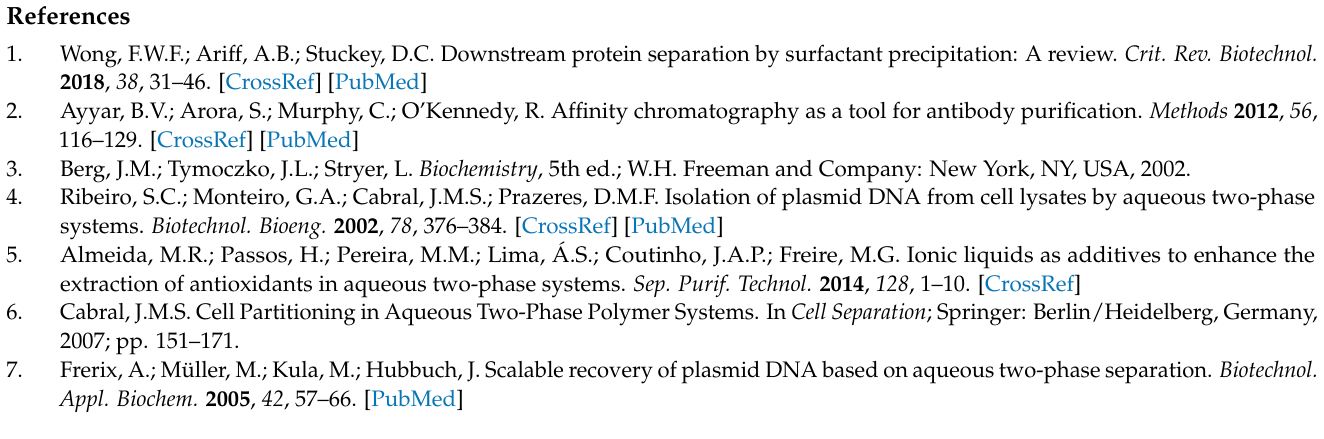
binodal curves of the ABS formed by [C 4 mim][MES] (1) + K 2 HPO 4 /KH 2 PO 4 (2) + H 2 O (3) at (25 ± 1) ◦ C and pH 7. Table S2: Experimental weight fraction data for the binodal curves of the ABS formed by [N 4444 ][MES] (1) + K 2 HPO 4 /KH 2 PO 4 (2) + H 2 O (3) at (25 ± 1) ◦ C and pH 7. Table S3: Experimental weight fraction for the binodal curves of the ABS formed by [P 4444 ][MES] (1) + K 2 HPO 4 /KH 2 PO 4 (2) + H 2 O (3) at (25 ± 1) ◦ C and pH 7. Table S4: Experimental weight fraction for the binodal curves of the ABS formed by [N 4444 ][Arg] (1) + K 2 HPO 4 /KH 2 PO 4 (2) + H 2 O (3) at (25 ± 1) ◦ C and pH 7. Table S5: Experimental weight fraction for the binodal curves of the ABS formed by [P 4444 ][Arg] (1) + K 2 HPO 4 /KH 2 PO 4 (2) + H 2 O (3) at (25 ± 1) ◦ C and pH 7. Table S6. Experimental weight fraction for the binodal curves of the ABS formed by [C 4 mim][Ac] (1) + K 2 HPO 4 /KH 2 PO 4 (2) + H 2 O (3) at (25 ± 1) ◦ C and pH 7. Table S7. Experimental weight fraction for the binodal curves of the ABS formed by [N 4444 ][Ac] (1) + K 2 HPO 4 /KH 2 PO 4 (2) + H 2 O (3) at (25 ± 1) ◦ C and pH 7. Table S8: Experimental weight fraction for the binodal curves of the ABS formed by [P 4444 ][Ac] (1) + K 2 HPO 4 /KH 2 PO 4 (2) + H 2 O (3) at (25 ± 1) ◦ C and pH 7. Table S9: Correlation parameters of Equations (1) and (2) used to describe the experimental binodal curve of the system. Table S10: Data of TLs and TLLs for the systems composed of IL + K 2 HPO 4 /KH 2 PO 4 buffer at pH 7 + H 2 O. [IL] and [salt] represents the compositions of IL and salt, respectively and content of water corresponds to the amount required to reach 100 wt%. Figure S15: Phase diagrams for the systems composed of IL + K 2 HPO 4 /KH 2 PO 4 buffer at pH 7 + H 2 O at 25 ◦ C: [C 4 mim][MES] ( • ); [N 4444 ][MES] ( (cid:7) ); [P 4444 ][MES] ( (cid:78) ); [N 4444 ][Arg] ( (cid:78) ); [P 4444 ][Arg] ( (cid:7) ); [C 4 mim][Ac] ( (cid:7) ); [N 4444 ][Ac] ( (cid:4) ); [P 4444 ][Ac] ( • ). Table S11: Extraction efficiencies ( EE% ) and yield of ABS composed of IL + K 2 HPO 4 /KH 2 PO 4 pH 7 + H 2 O for pure BSA. Table S12: Yield and purity of BSA from bovine serum by ABS composed of [N 4444 ][Ac] + K 2 HPO 4 /KH 2 PO 4 pH 7 + H 2 O. Figure S16. SE-HPLC Chromatogram with bovine serum dilution 1:15 ( v:v ) ( —- )), pure BSA 0.8 g · L − 1 ( —- ) and top-phase of the system [N 4444 ][Ac] + K 2 HPO 4 /KH 2 PO 4 buffer at pH 7 + bovine serum 1:15 ( v:v ) ( —-